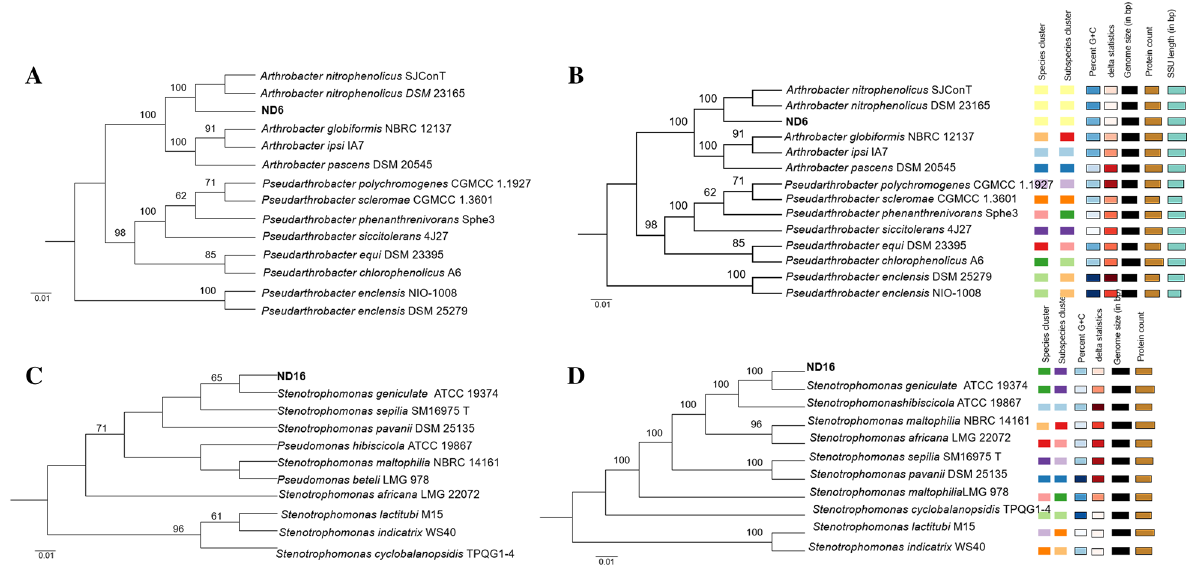
Fig. 2 Phylogenetic trees of strains ND6 ( A , B ) and ND16 ( C , D ) based on 16S rRNA gene sequences ( A , C ) and genome ( B , D